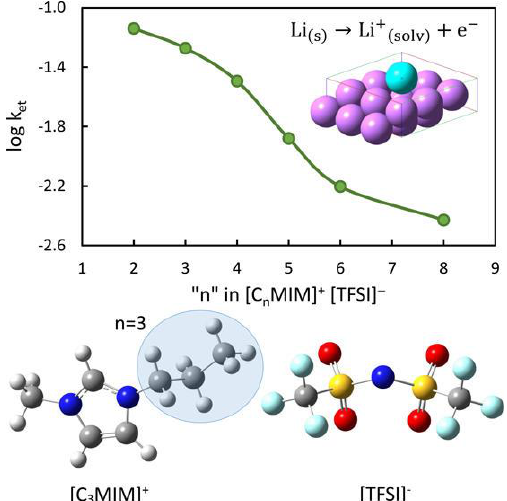
Figure 41. The electron transfer rates, as a function of the length of the side alkyl chain in imidazolium cation, n , is shown. The inset in the plot shows the structure of the lithium lattice where a lithium atom is ionized and ends up in solvated state. The chemical structure of the imidazolium based cation shows an example where n = 3. The TFSI anion’s structure is also provided. Reprinted with copyright permission from Kazemiabnavi et al. [80]. Copyright© 2014, American Chemical Society.